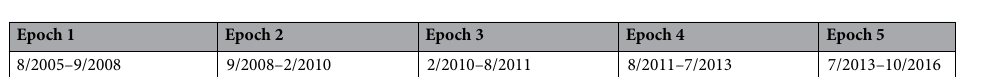
Epoch 1 Epoch 2 Epoch